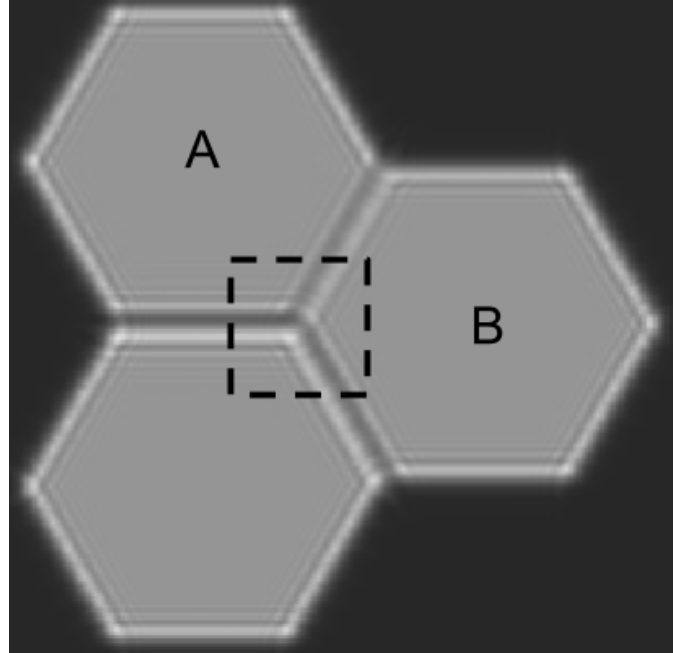
Figure 2. Diffraction image of three segments with piston errors between them. Distinctive intensity ripples at the borders between segments are caused by wavefront discontinuities. These discontinuities are, in turn, due to piston errors. Movement orders are commanded to segments A and B to minimize the effects of the errors between the